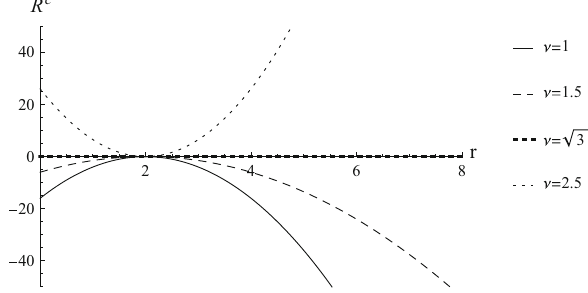
Fig. 5 The behavior of R c ( r ) as a function of r with r − = 1, r + = 2, ν = 1 ( L = − 0 . 586 ) , ν = 1 . 5 ( L c −